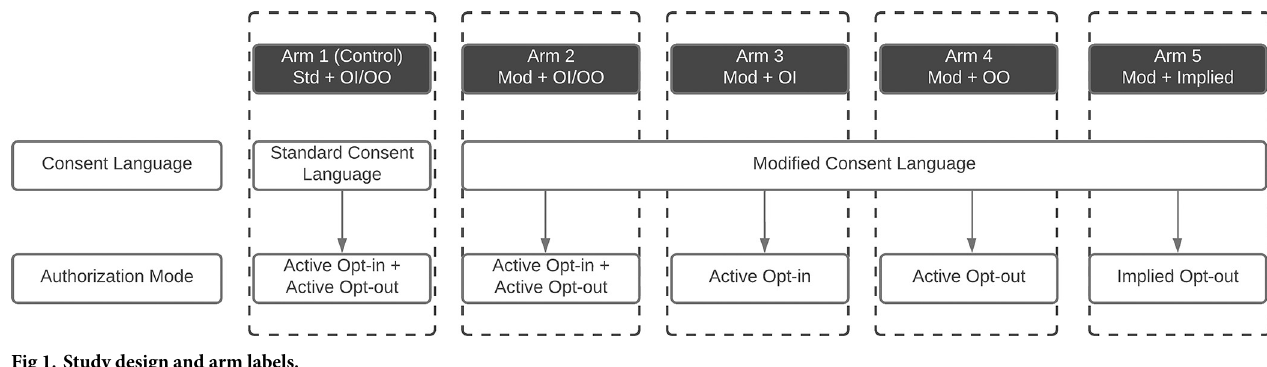
Fig 1. Study design and arm